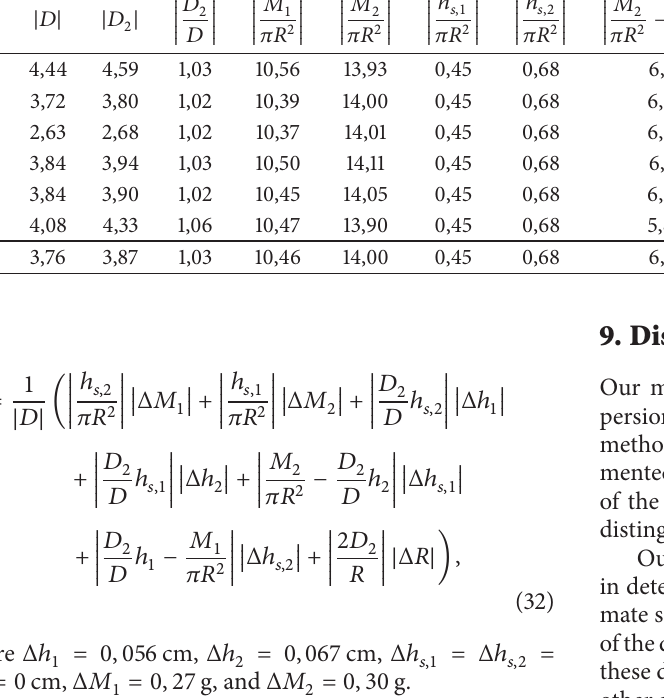
Table 3: Coefficient values of the absolute inaccuracies Δ𝑀 1 , Δ𝑀 2 ,Δℎ 1 ,Δℎ 2 ,Δℎ 𝑠,1 , Δℎ 𝑠,2 ,Δ𝑅 .